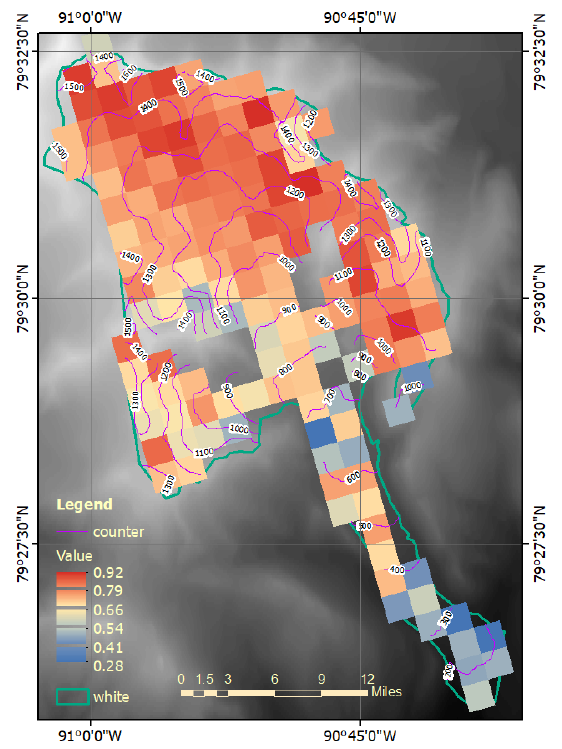
Figure 1 . Interpolation average summer albedo data in 2018.The purple line is counter of White Glacier, and bold green line is boundary of this glacier. The hollow in the middle is the location of the